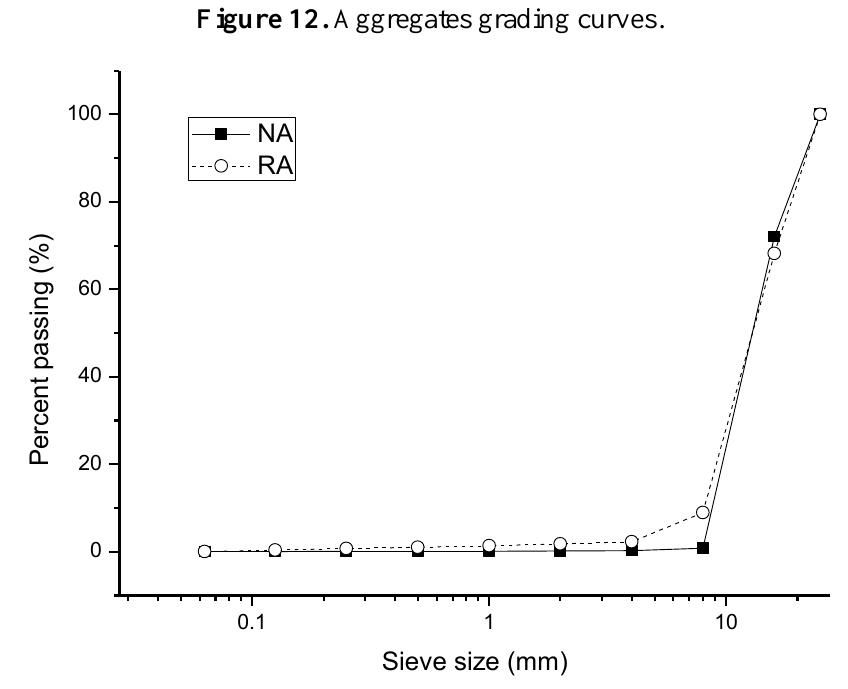
Figure 12. Aggregates grading